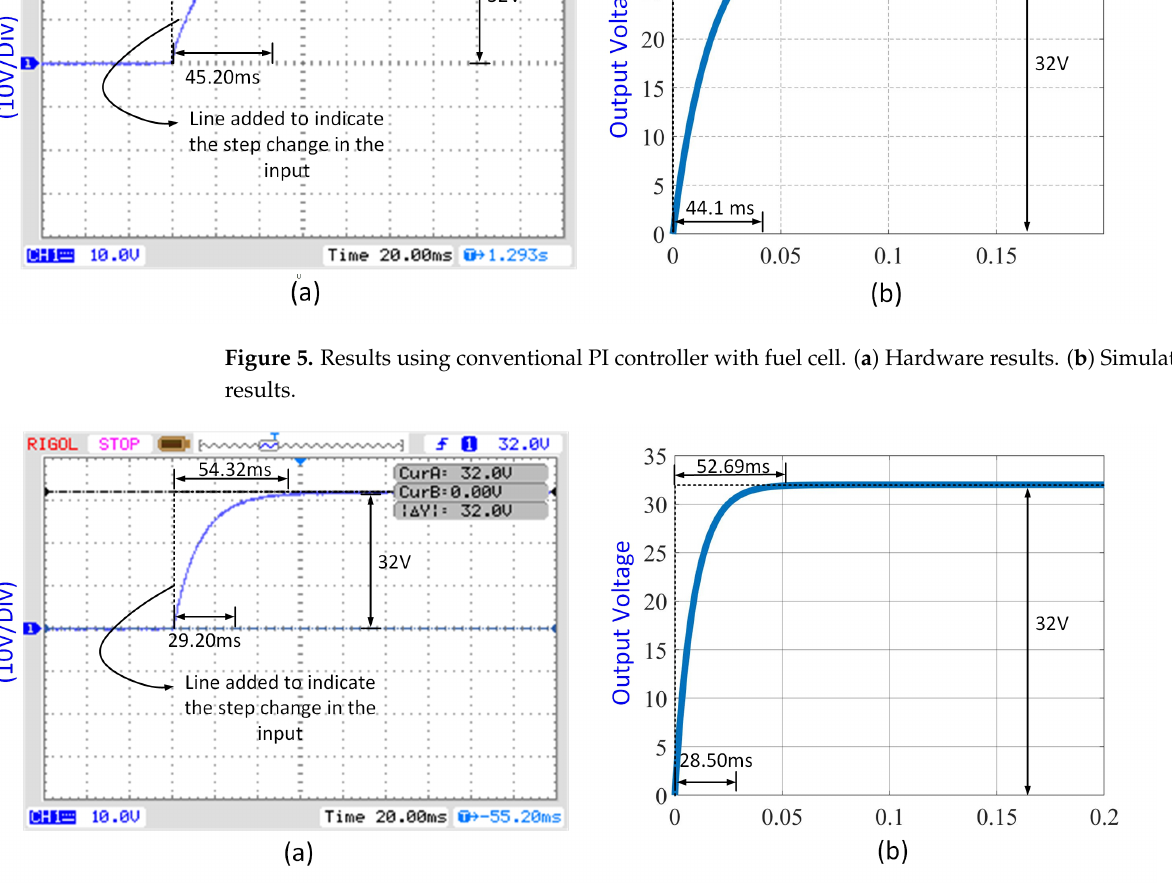
Figure 6. Results showing performance of the proposed DISMC with PEMFC. ( a ) Hardware results. ( b ) Simulation